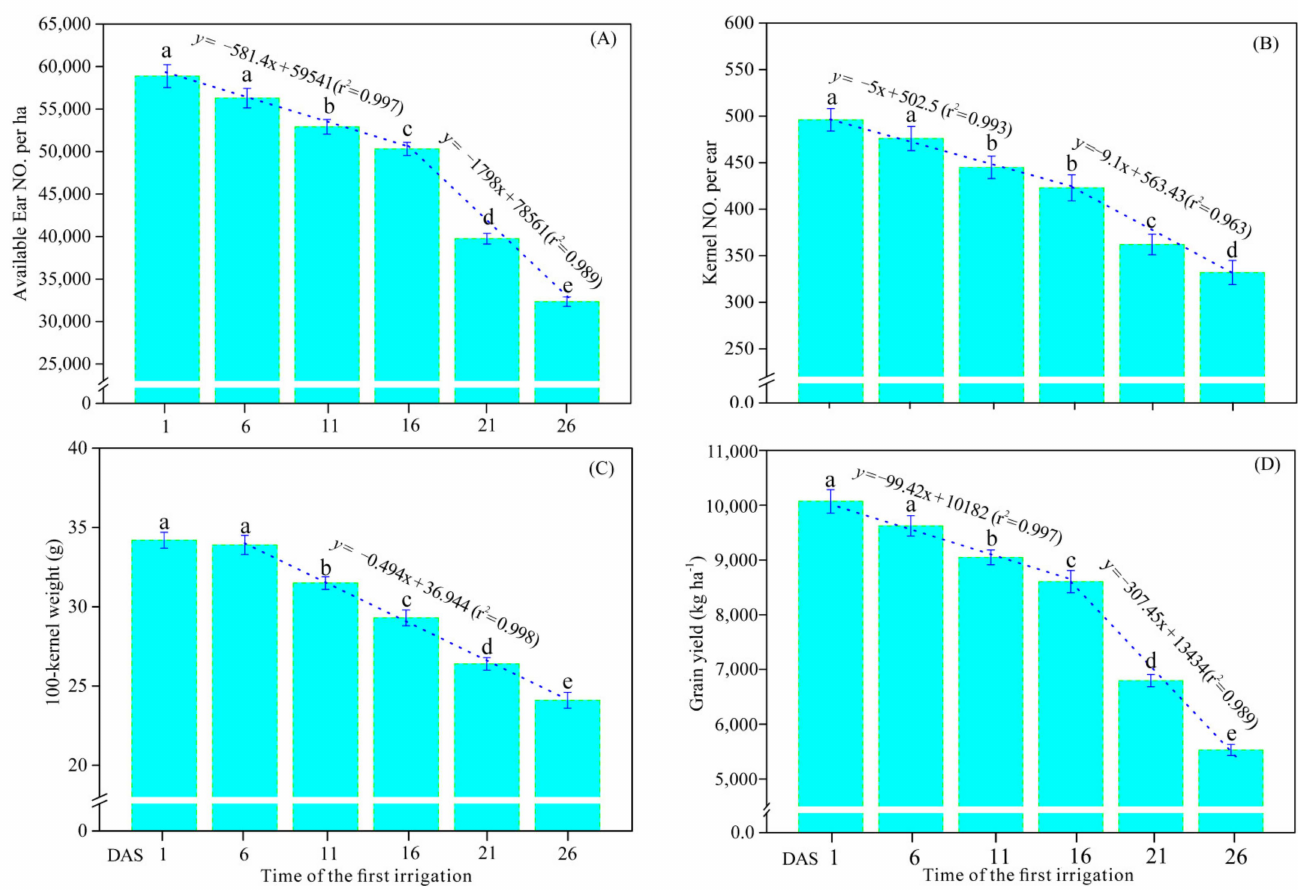
Figure 4. Effects of time of the first irrigation (DAS: days after sowing) on yield components (( A ): available ear number per ha; ( B ): kernel number per ha; ( C ): 100-kernel weight) and grain yields ( D ) of summer maize under a plant density of 6.75 × 10 4 plants ha − 1 in the North China Plain. Different letters indicate significant differences at p <